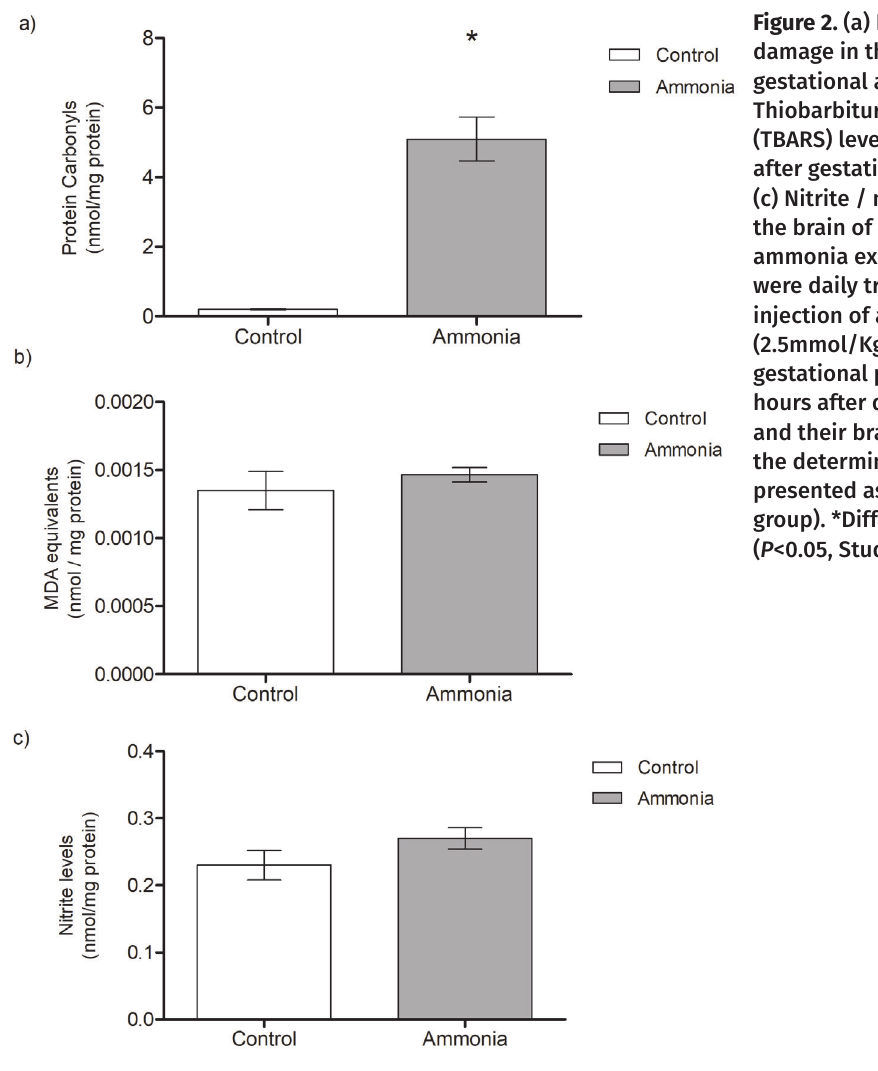
Figure 2. (a) Protein oxidative damage in the brain of pups after gestational ammonia exposure. (b) Thiobarbituric acid reactive species (TBARS) levels in the brain of pups after gestational ammonia exposure. (c) Nitrite / nitrate (nox) levels in the brain of pups after gestational ammonia exposure. Pregnant rats were daily treated with a single injection of ammonium acetate (2.5mmol/Kg) or saline during all gestational period. Twenty-four hours after delivery pups were killed and their brains were removed to the determination of nox. Data are presented as mean ± SD, (n=10, each group). *Different from control, ( P <0.05, Student T